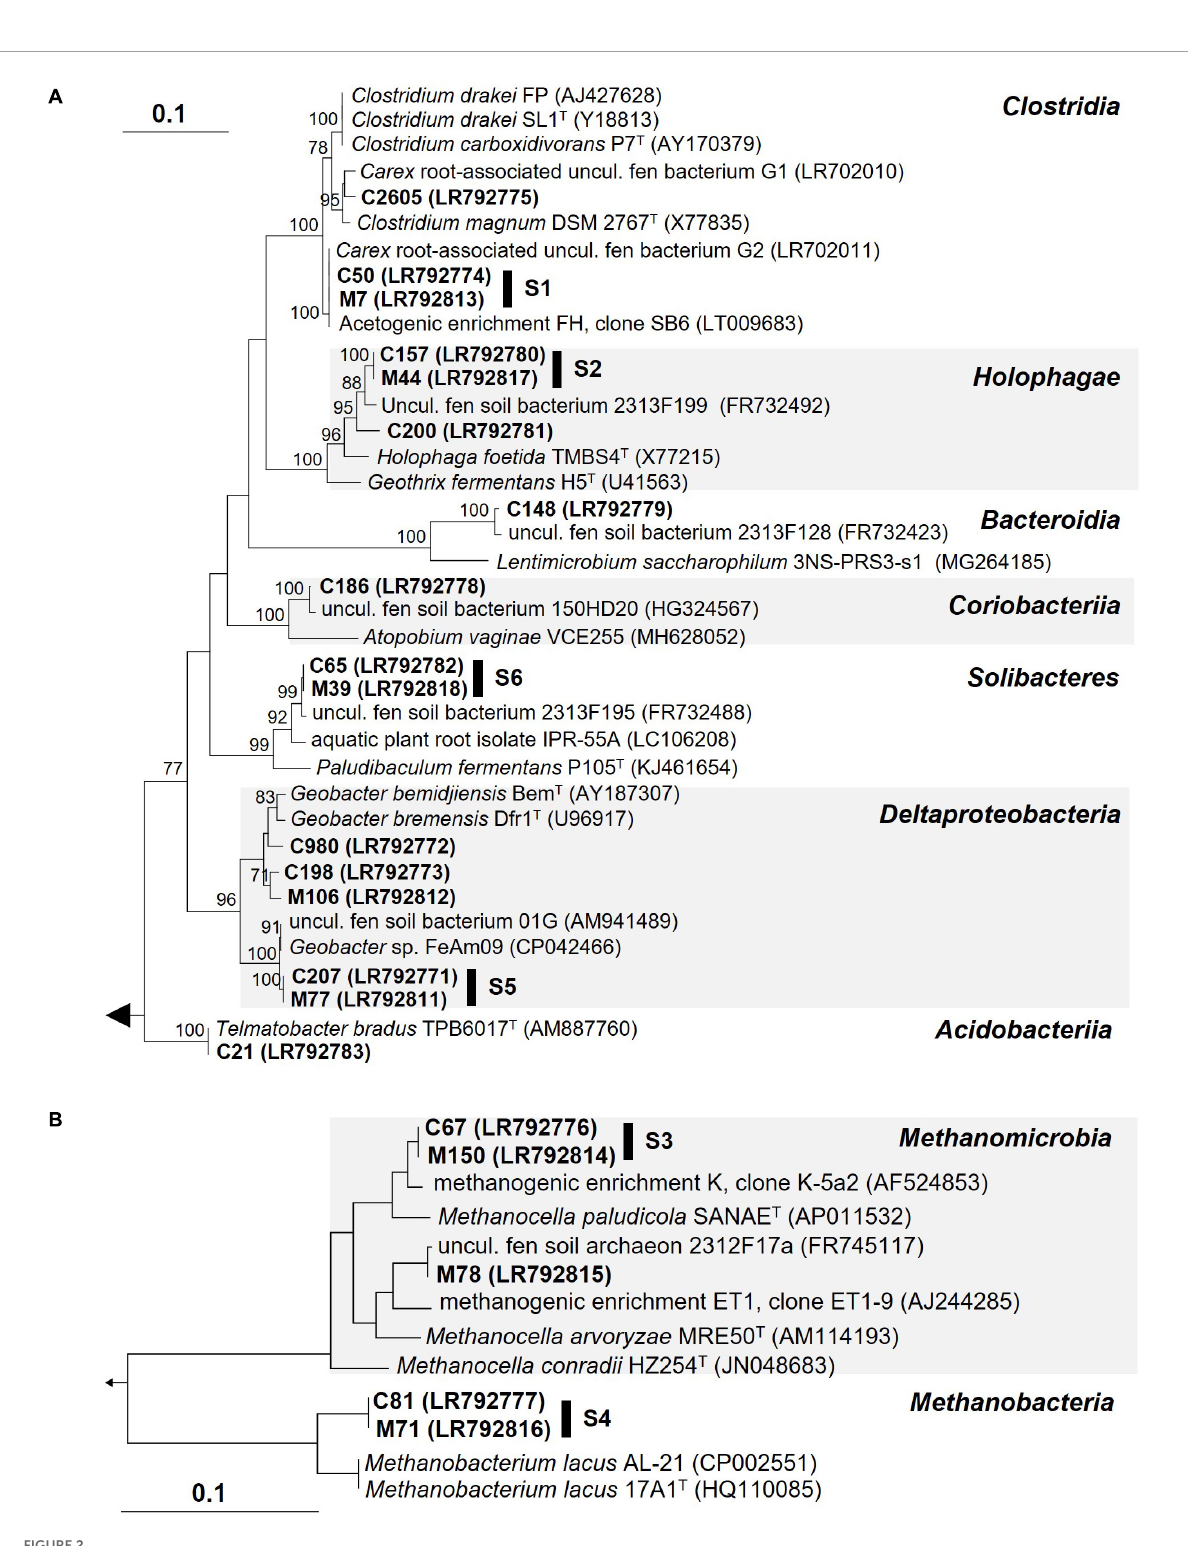
FIGURE2 16S rRNA gene-based phylogenetic trees of bacterial (A) or archaeal (B) phylotypes stimulated by supplemental H 2 in root-free soil treatments (bold; see Table 2 ) and related prokaryotes. S, shared phylotypes (i.e., Carex phylotypes that shared 100% 16S rRNA gene sequence similarity with Molinia phylotypes). The phylogenetic trees were calculated using the neighbor joining function (correction model: Jukes-Cantor) implemented in the ARB software (Ludwig et al., 2004). Bootstrap values (1,000 resamplings) higher than 70% are shown. Methanosarcina acetivorans C2A (AE010299) and Telmatobacter bradus TPB6017 (AM887760) were used as outgroup in (A,B) ,